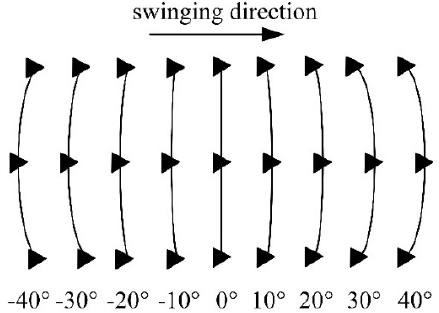
Figure 16. Schematic of spanwise flexibility and γ value.